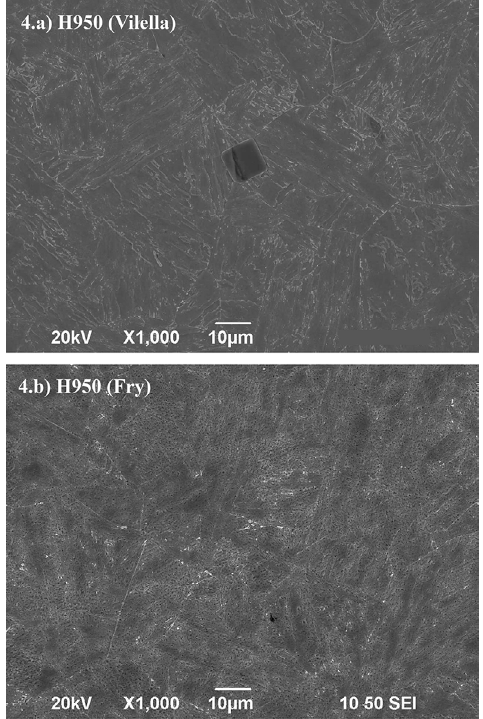
Figure 4. SEM images of H950, etched with: (a) Vilella and (b) Fry.